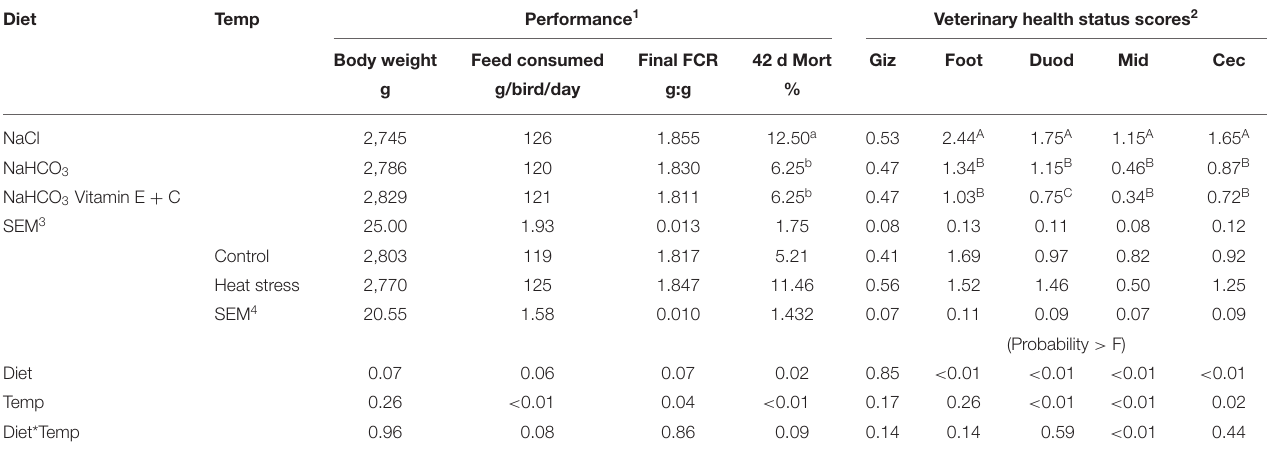
Temp 0.26 < 0.01 0.04 Diet*Temp 0.96